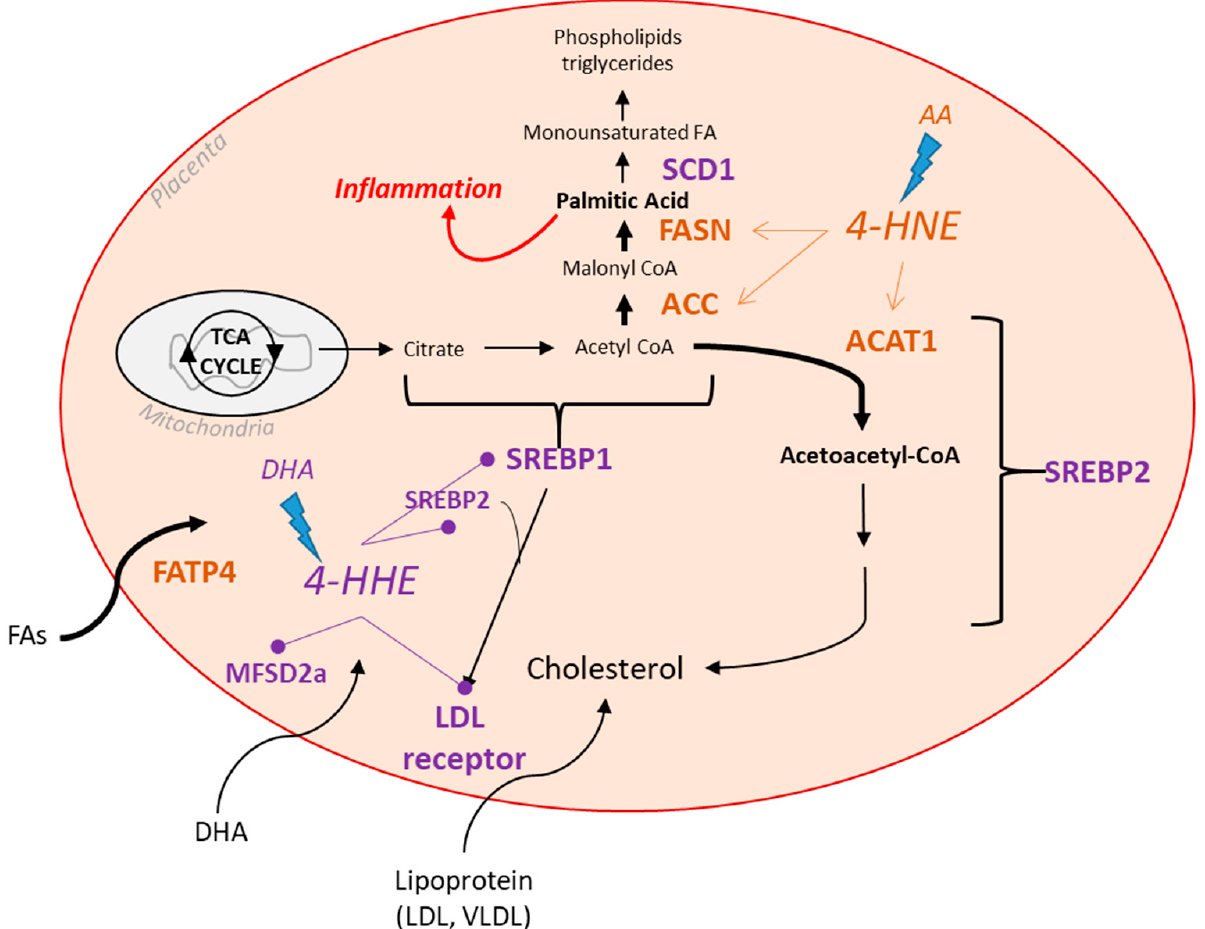
Figure 3. Summary and proposed model of the impact of 4-HHE and 4-HNE on placental lipid metabolism pathways. 4-HNE, an oxidative by-product of the n-6 LCPUFA, arachidonic acid (AA), drives an overall increase (orange) in lipogenesis and uptake genes. Increased ACC and FASN may produce more palmitic acid, whereas increased ACAT1 may heighten cholesterol synthesis. Higher levels of the fatty acid transporter FATP4 may increase the uptake of FAs. 4-HHE, an oxidative by-product of the n-3 LCPUFA, DHA, drives a decrease (purple) in the lipogenesis genes SREBP1 and SREBP2, which may decrease overall FA and cholesterol synthesis. Lower SREBPs may drive decreases in LDL receptors and cholesterol uptake. Low MFSD2a levels may reduce DHA uptake. Reduced SCD1 by 4-HHE impairs the last step in FA synthesis, potentially resulting in a build-up of the saturated palmitic acid, which may lead to the inflammation we see in placentas undergoing oxidative stress.